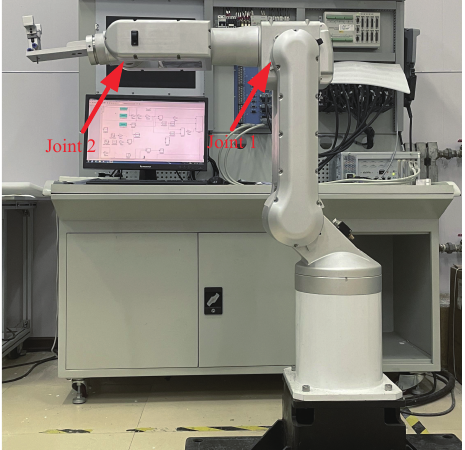
Figure 1. The multi-joint industrial robot servo